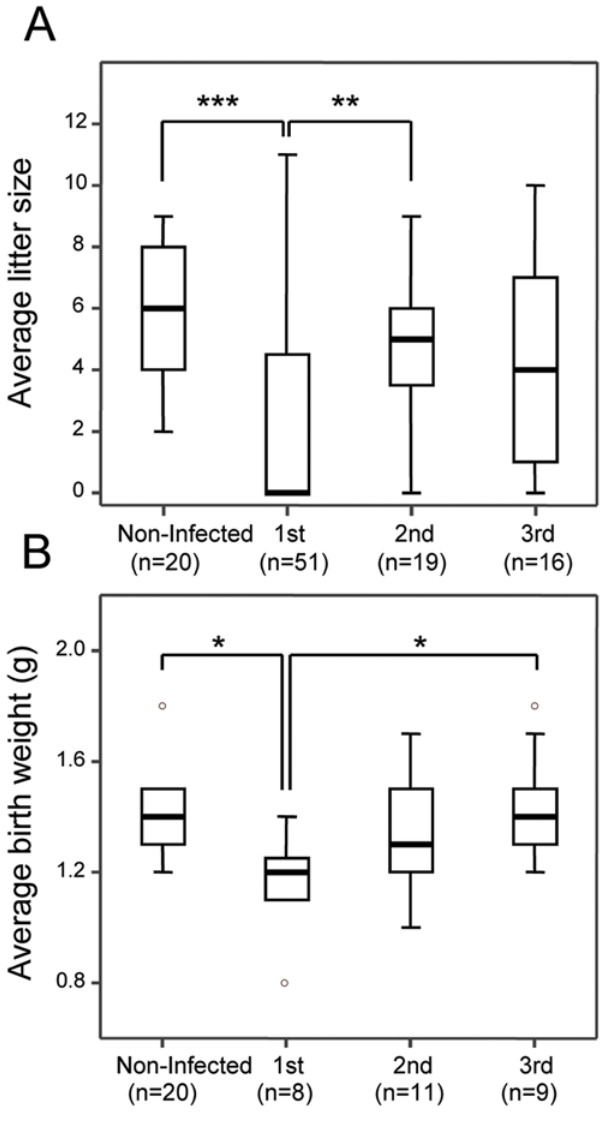
Figure 6. Reduced adverse pregnancy outcomes in multigrav- ida. Box-plots of the average litter size (A) and average newborn birth weight (B) according to parity (first, second and third pregnancy). Pregnancy outcome was significantly different in primigravida as compared to multigravida and non-infected pregnant females (***, P - value , 0.001; **, P -value , 0.01; *, P -value , 0.05).